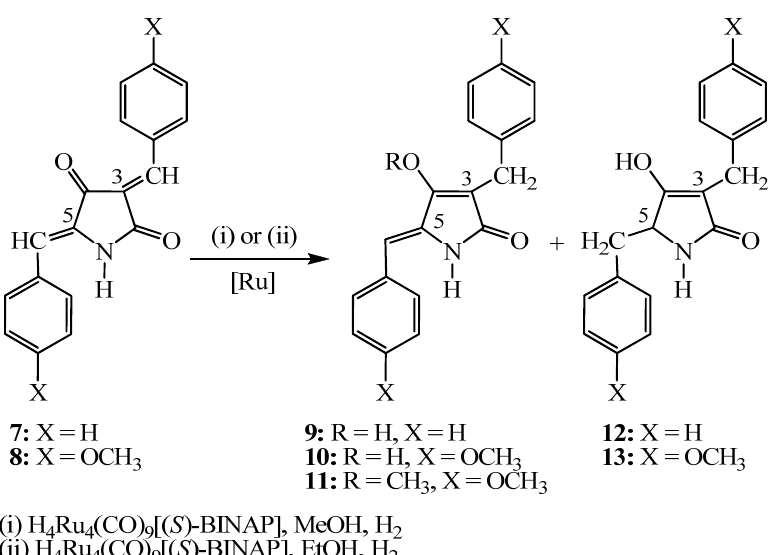
Scheme 2. Hydrogenation of compounds 7 and 8